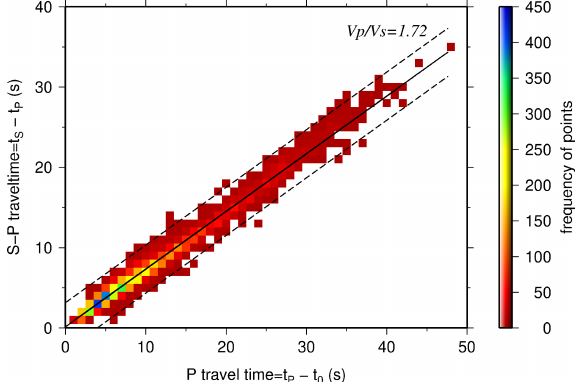
Figure 3. Modified Wadati diagram based on P and S picks after visual (manual) analysis (the color indicates number of picks; please see the color palette table on the right). The origin times ( t 0 ) of the earthquakes are provided by the single-event localization using HYPO71 hypocenter determination program (Lee and Lahr, 1975). The solid black line shows the fit to the data by linear least squares, and its slope indicates the V P /V S ratio of 1.72. The dashed lines show values with t s − t p = 0 . 72 t p ± 3s.